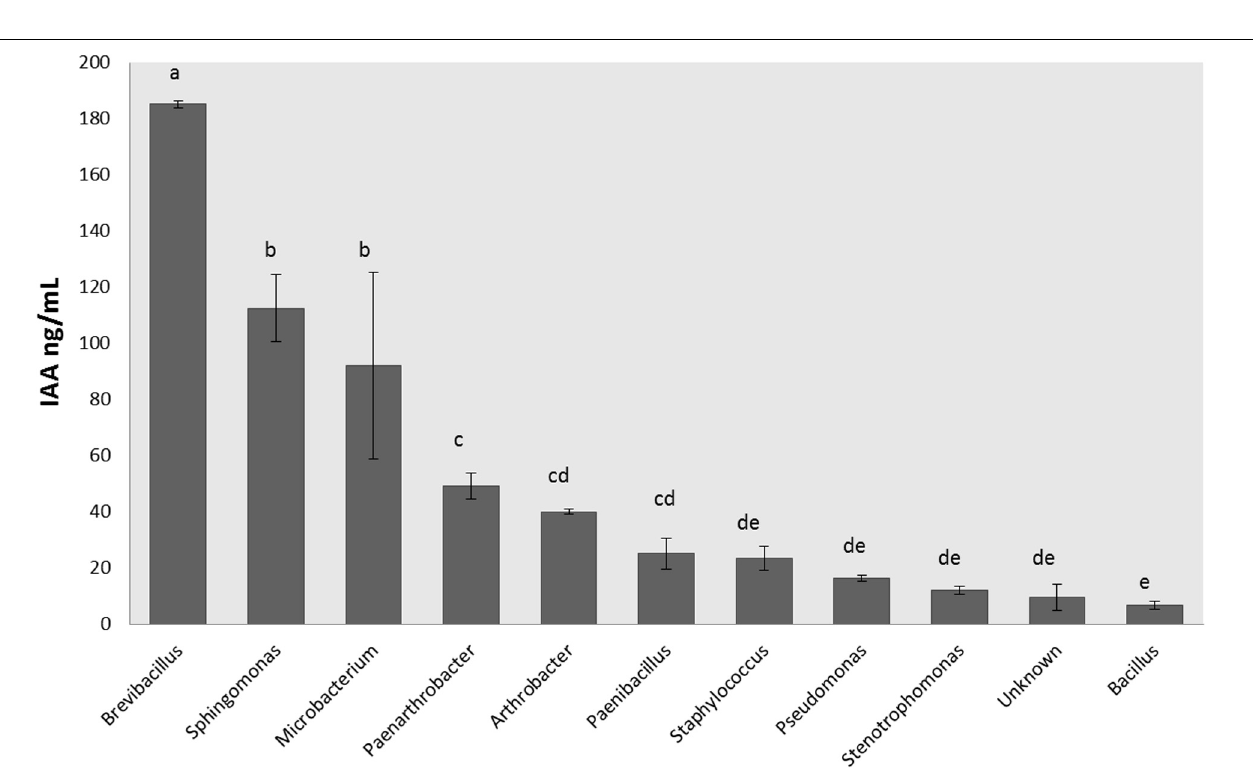
FIGURE 3 | Production of indole-3-acetic acid by endophytic isolates according the genus. Indole-3-acetic acid production was measured in ng per mL after 20 h of growth at 28 ◦ C in LB medium supplemented with Trp 5 mM. Production was measured in triplicates for each isolate, and the final concentration was obtained after standardization. Bar errors represent the standard error. Letters represent the significant groups after ANOVA and HSD Tukey post-hoc tests. Signification threshold: p ≤ 0.05.